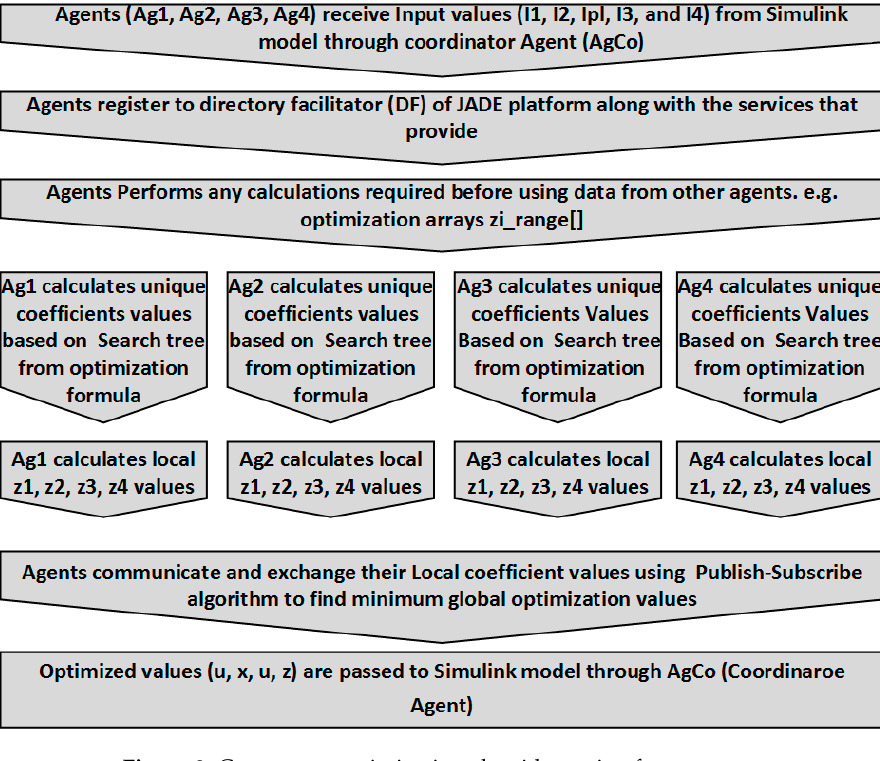
Figure 9. Concurrent optimization algorithm using four agents.